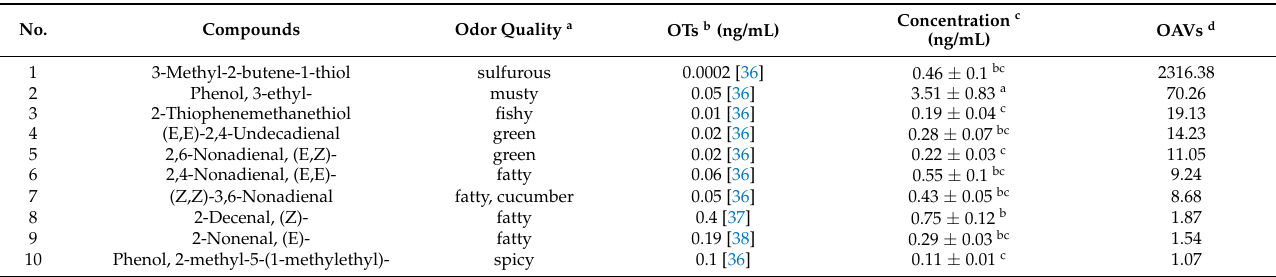
Table 3. Specific aroma components with OAV > 1 in